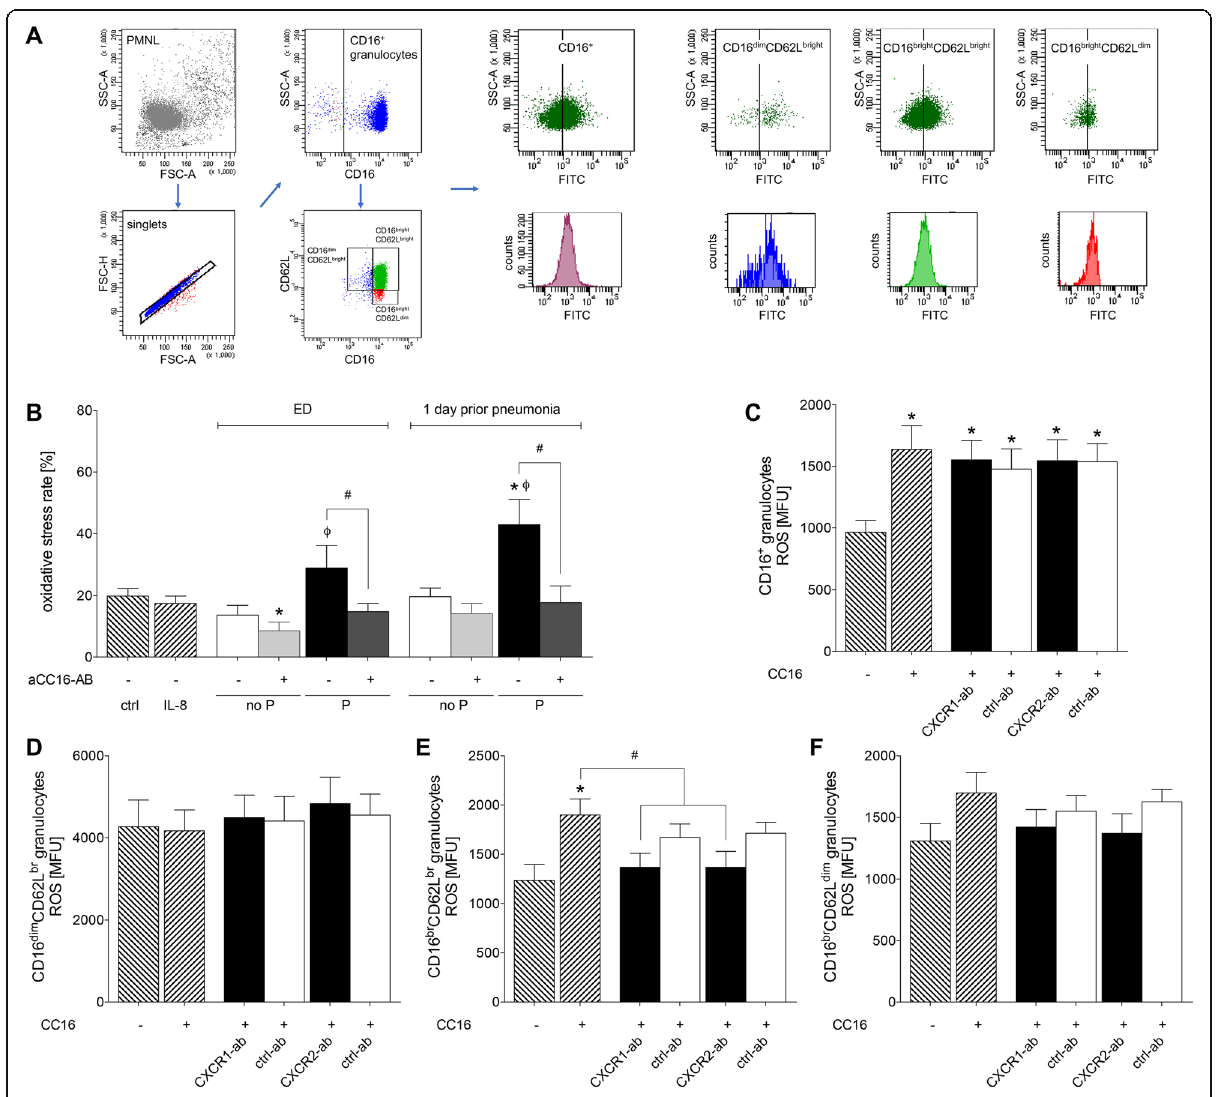
Fig. 3 CC16-induced oxidative burst notably in the group of traumatized patients who develop complications is associated with CXCR1 and CXCR2 in mature neutrophils. a Gating strategy of isolated PMNL and representative stainings for CD16 and subsequent gating of CD16CD62L subsets with the exemplary MFU evaluation is shown. b Oxidative stress rate of PMNL after their incubation with IL-8 or sera samples from severely injured trauma patients. Patients were grouped to no P group without pneumonia or P group with to pneumonia. Samples were obtained at admission to emergency department (ED) and one (Sadeghi-Bazargani et al. 2018) day prior pneumonia. Samples from the equal post-injury days in the corresponding no P group were used. c Oxidative burst activity in CD16 + granulocytes after incubation with CC16 and neutralization of CXCR1 (CXCR1-ab), CXCR2 (CXCR2-ab) or the corresponding isotype control antibodies (ctrl-ab), respectively. d Oxidative burst activity of immature CD16 dim CD62L bright , ( e ) mature CD16 bright CD62L bright and ( f ) immunesuppressive CD16 bright CD62L dim granulocytes. Data are represented as mean ± SEM. p < 0.05: *: vs. ctrl; #: CC16 vs.